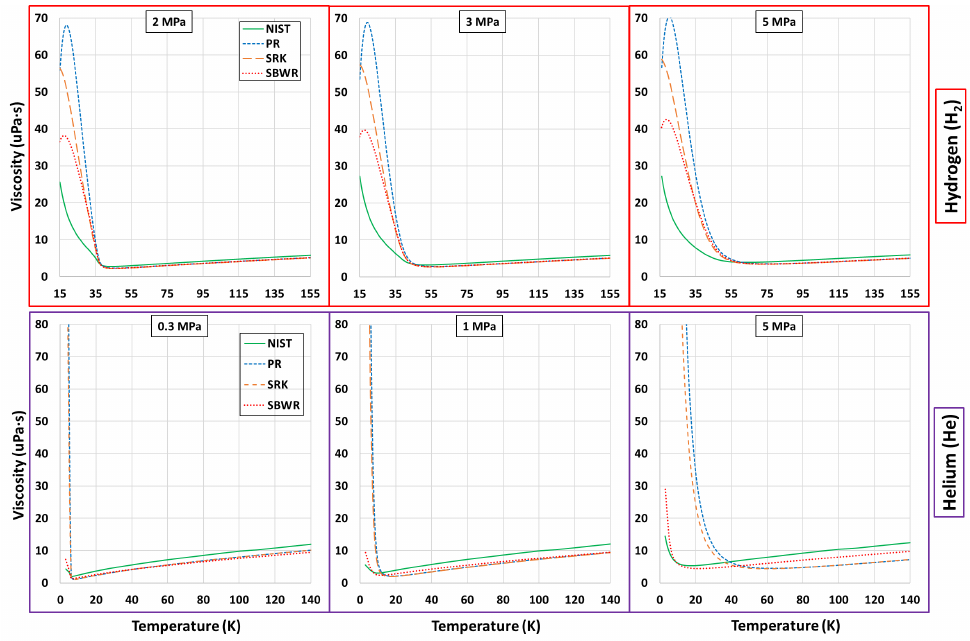
Figure A2. Plots of estimated viscosity using Chung et al.’s model and density from PR, SRK and SBWR compared against NIST for cryogenic fluids-H 2 and He at three supercritical